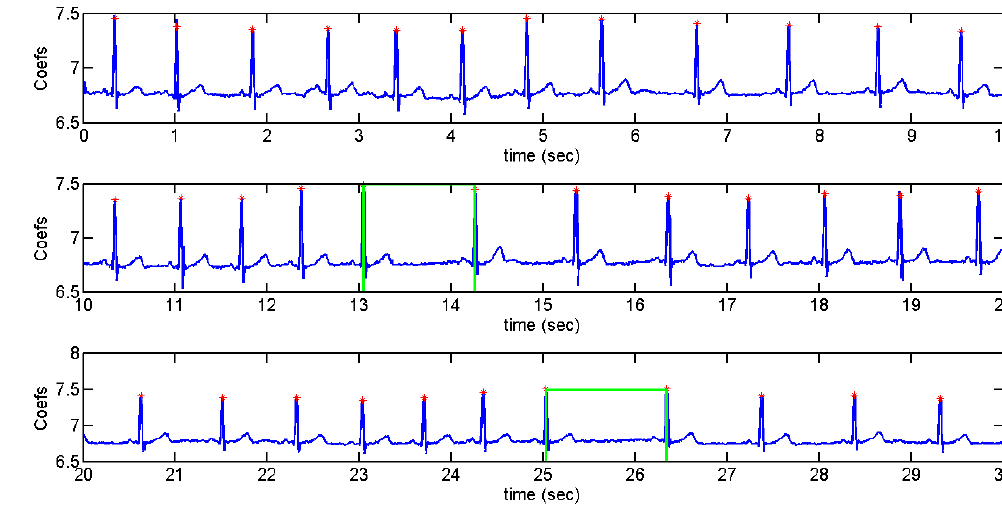
Figure 24. Arrhythmias detected in User